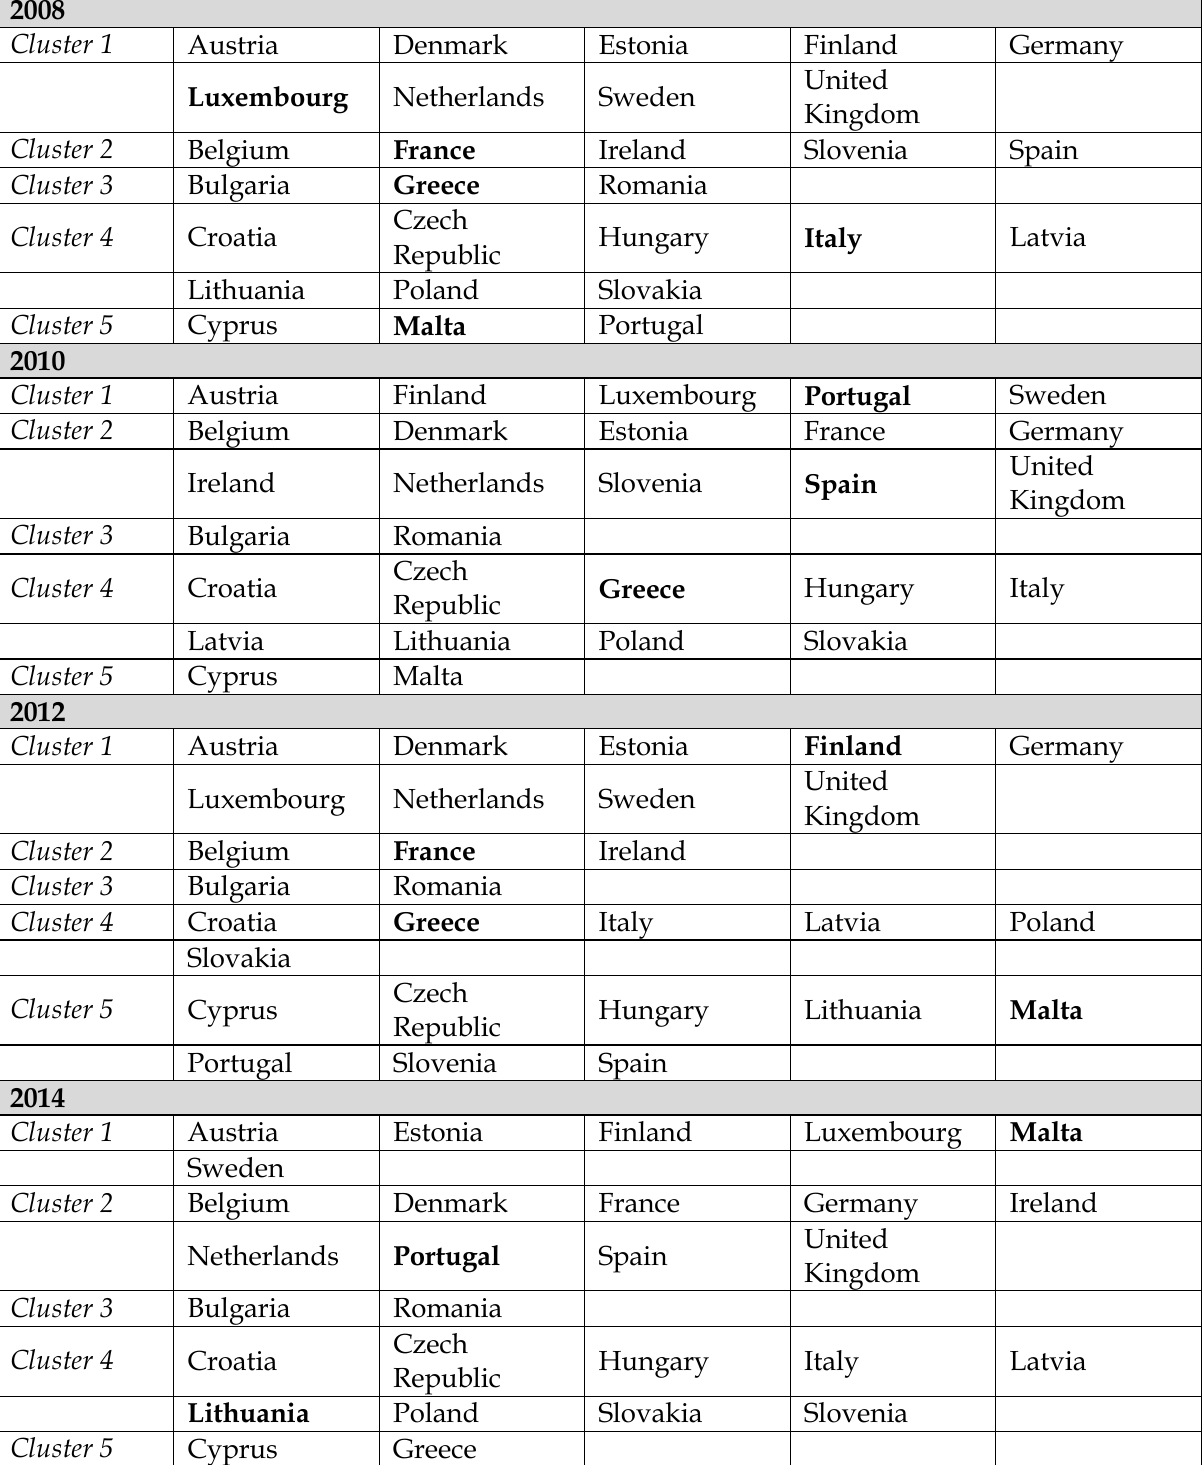
Table 3: Clustering in 2008, 2010, 2012 and 2014 using k-means